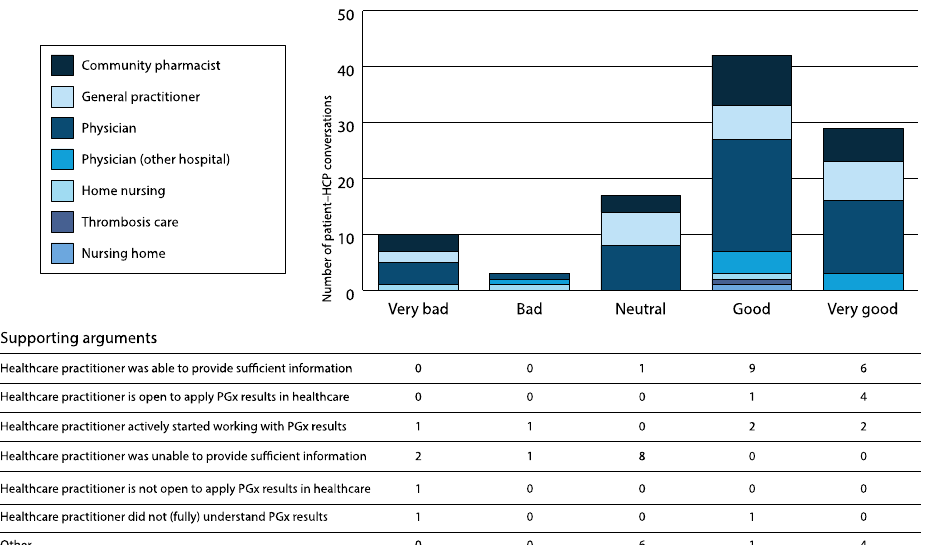
Figure 2. Conversation scores for the discussion of pharmacogenomic test results with healthcare practitioners. The number of conversations between patients and different healthcare practitioners, the score patients gave to those conversations, and the supporting arguments for the score given.